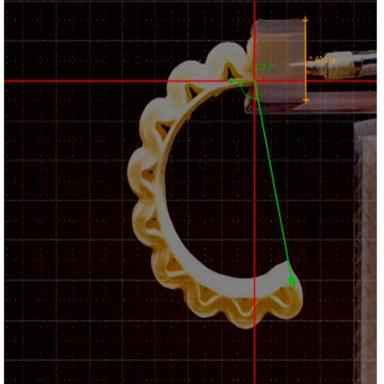
Displacement analysis (25 psi).